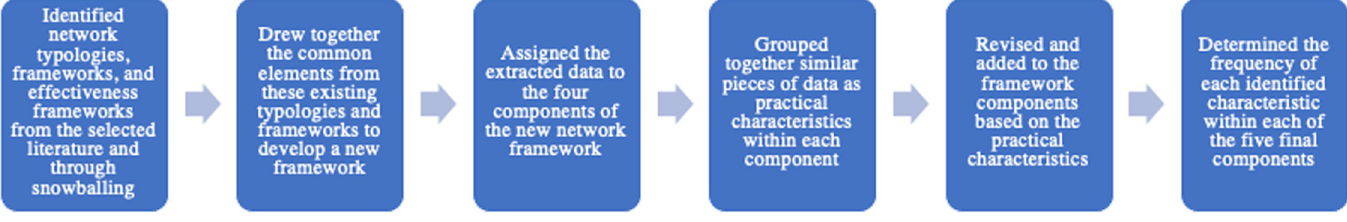
Fig 2. Process of synthesizing the charted